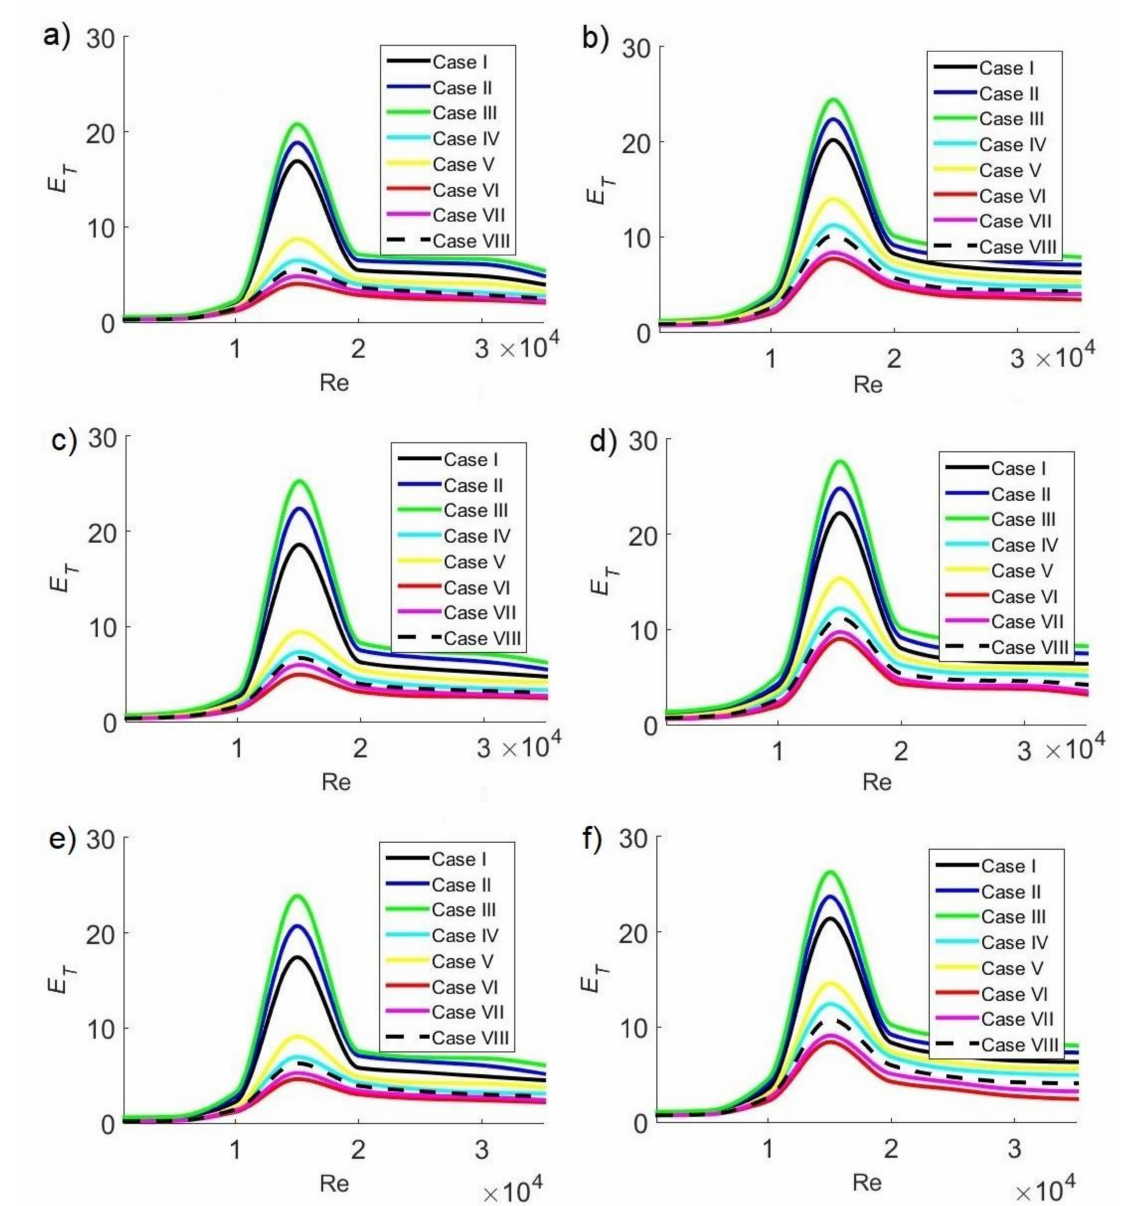
Figure 9. Global ventilation effectiveness for air temperature distribution in the classroom as a function of the Reynolds number at 11:30 a.m. with CO 2 sources of ( a ) 35,000 ppm and ( b ) 42,500 ppm; at 3:30 p.m. with CO 2 sources of ( c ) 35,000 ppm and ( d ) 42,500 ppm; and at 6:30 p.m. with CO 2 sources of ( e ) 35,000 ppm and ( f ) 42,500